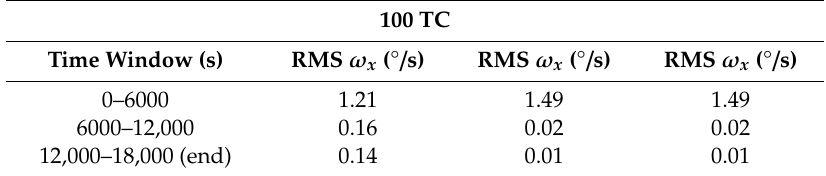
Table 8. Mean Root Mean Square of the angular rates estimation errors for the 100 Test